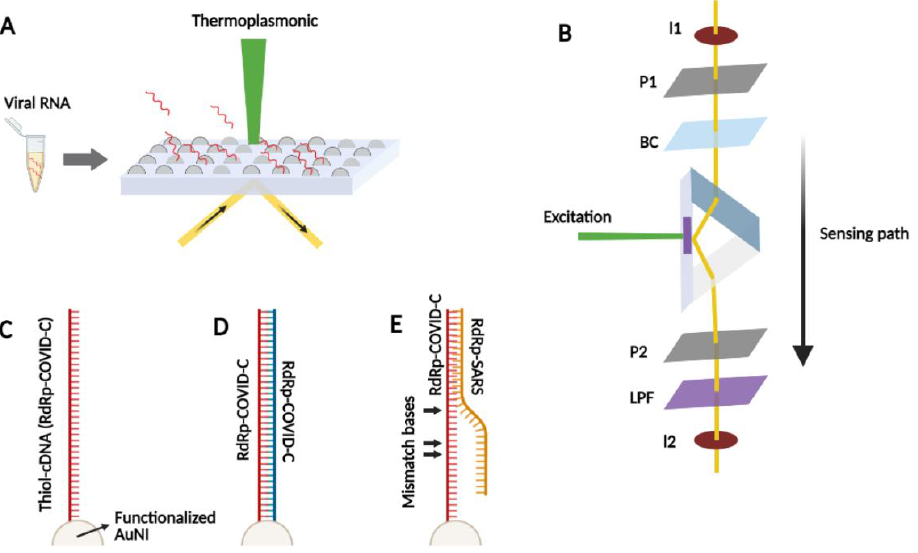
Figure 4. The schematics of the developed dual-functional plasmonic biosensor. ( A ) the overall structure of the sensor combining the PPT effect and LSPR for detection of the virus genetic material. ( B ) The dual-functional PPT enhanced LSPR biosensing system including the aperture-iris (I1/I2), the linear polarizers (P1/P2), the birefringent crystal (BC), and totally reflected at the interface of AuNI-dielectric for LSPR detection. A laser diode (LD) generates the PPT effect on AuNIs. ( C ) AuNI functionalization based on the reaction with thiol-cDNA ligands. ( D ) Illustration of the hybridization between two complementary strands, the reporter DNA, and the target sequence in SARS-CoV-2 genome. ( E ) Specific hybridization of the functionalized thiol-cDNA and inhibiting partial adhesion of RdRp-SARS sequence with two mismatches.